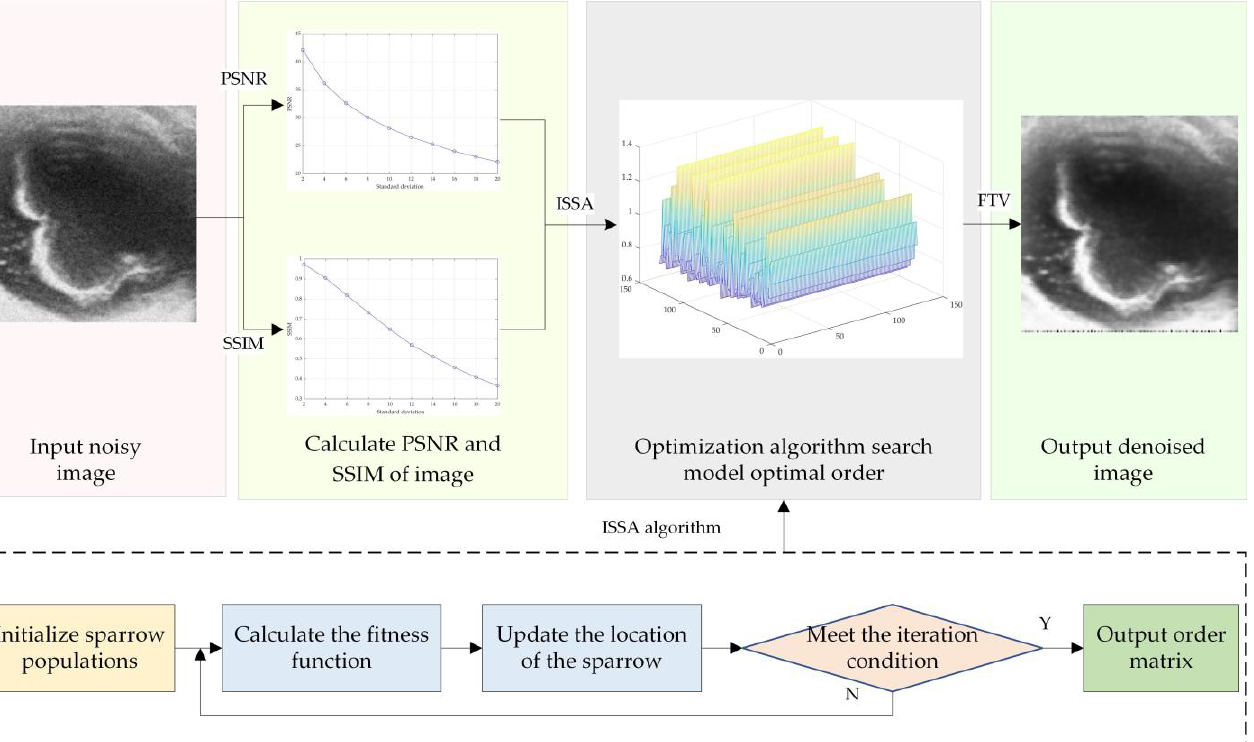
Figure 2. The framework of the proposed algorithm.